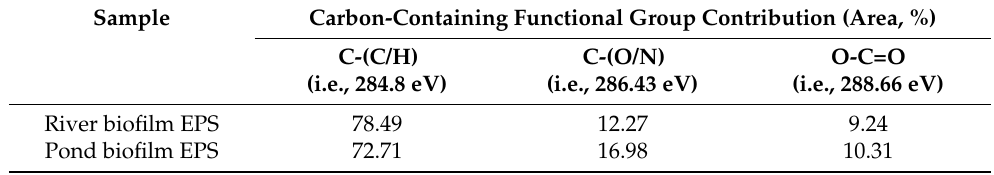
Table 1. Characterization of carbon-containing functional groups of EPS via XPS